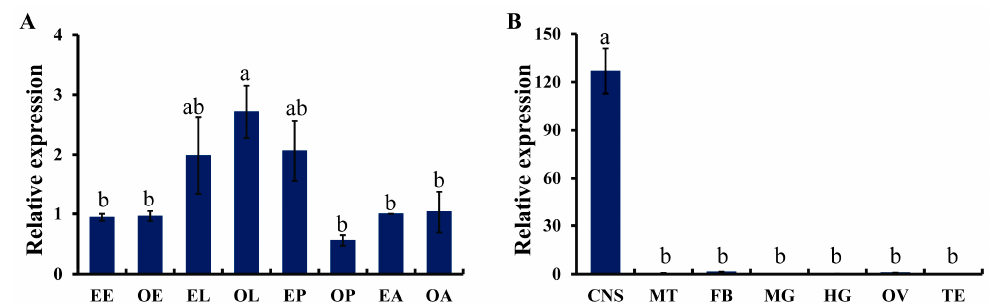
Figure 3. The expression profiling of TcT β H . ( A ) Relative expression levels of TcT β H at different developmental stages. The first letters, E and O represent early and old. Different stages are displayed by capitalized letters: E (egg), L (larva), P (pupa), and A (adult). The expression of EA served as the calibrator; ( B ) Relative expression levels of TcT β H in various tissues of adults. CNS: central nervous system; FB: fat body; MG: midgut; MT: Malpighian tubules; OV: ovary; TE: testis. The data shown are the mean of the relative expression ± standard error (S.E.) ( n = 3), normalized to RPS3 transcript levels. Different letters (a, ab, b) above the bar represent a significant difference after ANOVA (least